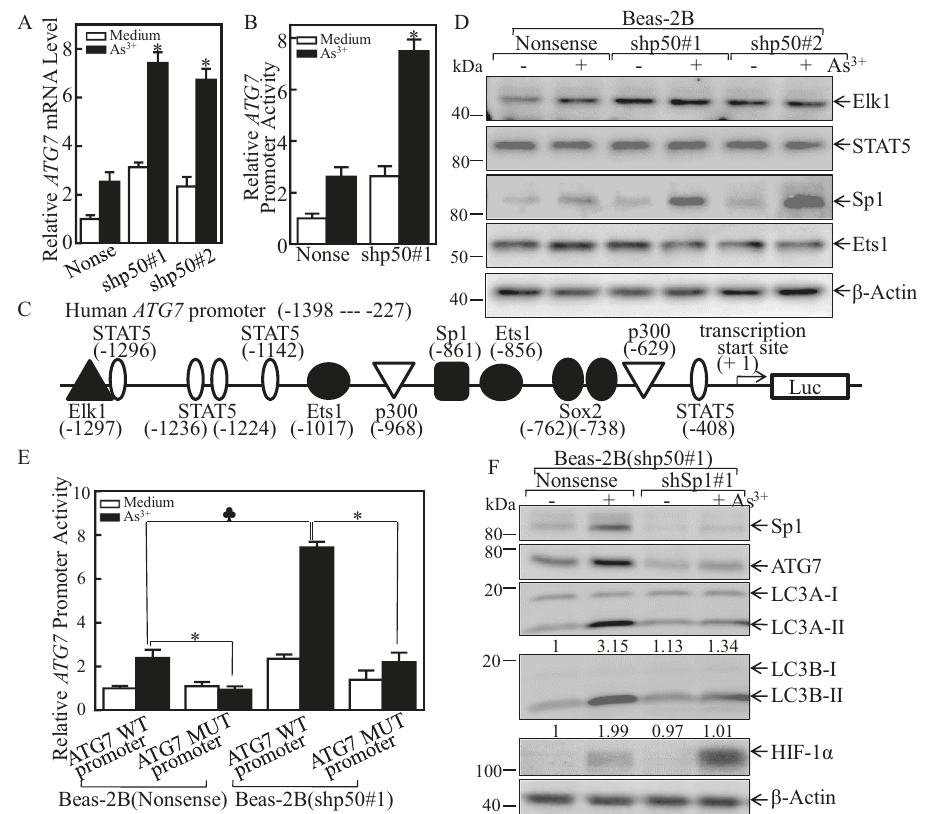
Fig. 4 p50 attenuated ATG7 transcription and expression by inhibition of Sp1 expression following arsenite treatment. A Beas- 2B(Nonsense) and Beas-2B(shp50) cells were treated with 20 μ M arsenite and the ATG7 mRNA expression was determined by Real-Time PCR assay; The symbol (*) indicates a signi fi cant increase as comparison to WT cells treated with arsenite ( p < 0.05). B The ATG7 promoter-driven luciferase reporter was transfected into Beas-2B(Nonsense) and Beas-2B(shp50) cells. The stable transfectants were subjected to 20 μ M arsenite treatment for 12 h, and the cell extracts were subjected to luciferase activity assay to evaluate relative ATG7 promoter transcriptional activity. The bars show mean ± SD from 3 independent experiments. The symbol (*) indicates a signi fi cant increase as comparison to WT cells treated with arsenite ( p < 0.05). C Potential transcription factor binding sites in the ATG7 promoter region ( − 1398 to − 227) were analyzed using the TRANSFAC 8.3 engine online. D Beas-2B(Nonsense) and Beas-2B(shp50) cells were treated with 20 μ M arsenite for 24 h. The cells were extracted and cell lysates were subjected to western blot by using the indicated antibodies. E Wild-type or mutant ATG7 promoter- driven luciferase reporters was co-transfected together with pRL-TK into Beas-2B(Nonsense) and Beas-2B(shp50) cells. 24 h post-transfection, the transfectants were extracted to evaluate the luciferase activity. The results were presented as relative ATG7 promoter activity in response to arsenite exposure. Each bar indicates mean ± SD from 3 independent experiments. The asterisk (*) indicates a signi fi cant decrease compared with wild-type reporter transfectant ( p < 0.05). The spade ( ♣ ) indicates a signi fi cant increase compared with Beas-2B(Nonsense) cells ( p < 0.05). F The stable transfectants as indicated were exposed to 20 μ M arsenite for 24 h. Cell extracts were subjected to Western blot, the ratio of LC3 II/LC3 I was quanti fi